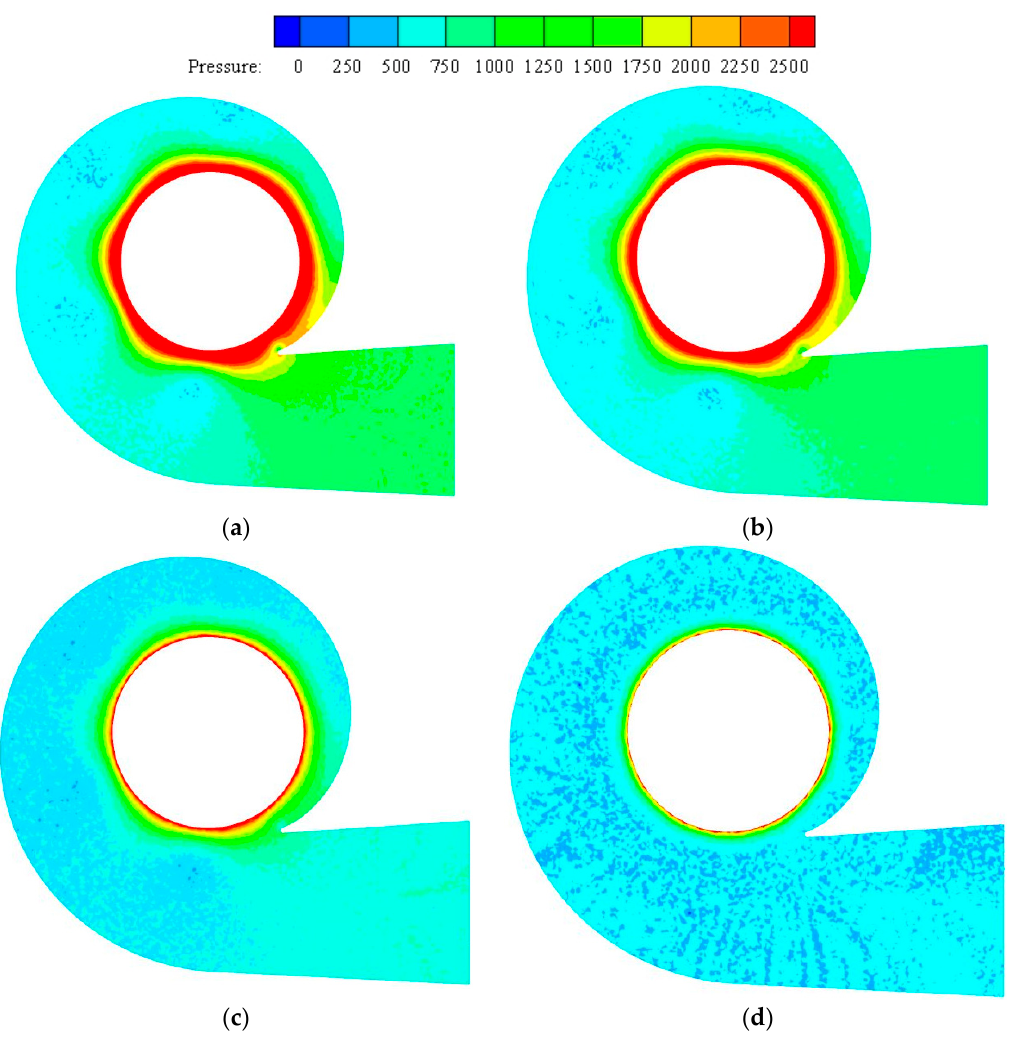
Figure 14. The standard deviation of pressure on mid-span of volute at t = 0.92 s at 1.0 Q n . ( a ) Case0; ( b ) Case10; ( c ) Case20; ( d ) Case30.